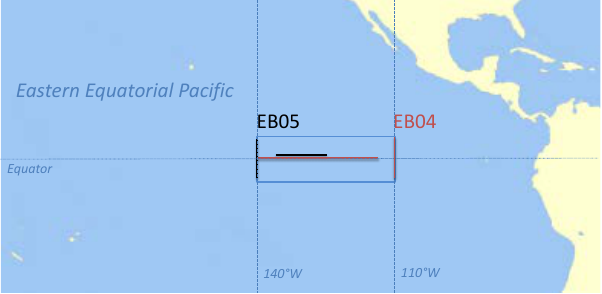
Fig. 1. Location of the eastern equatorial Pacific Ocean study area. Red lines indicate the location of EB04 cruise sampling transects from December 2004, and blue lines indicate the location of EB05 cruise sampling transects from September